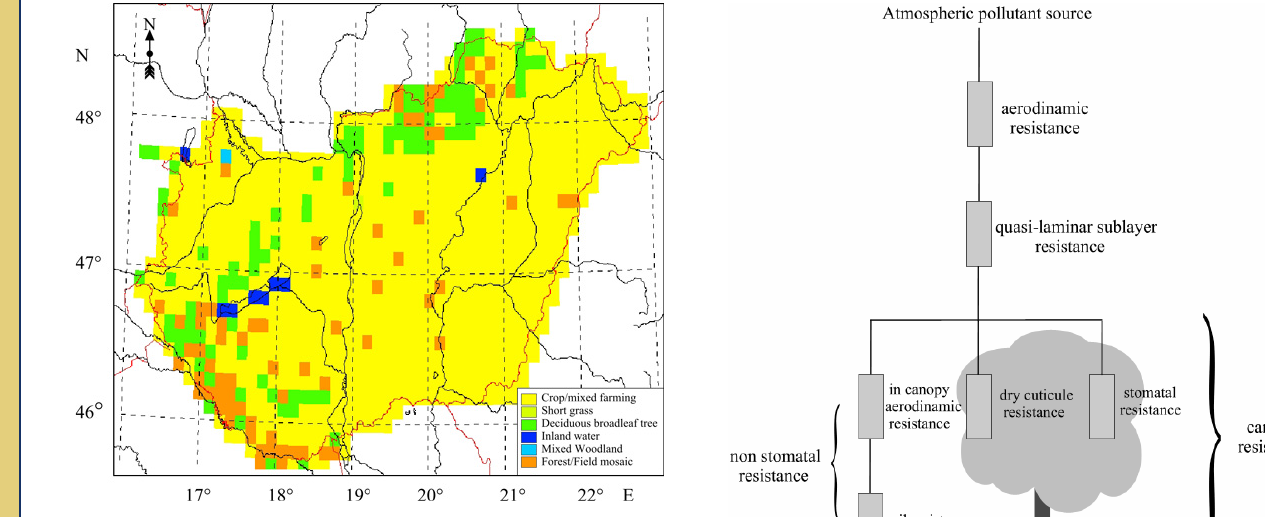
Figure 1. Land use categories over Hungary in RegCM-3 model.